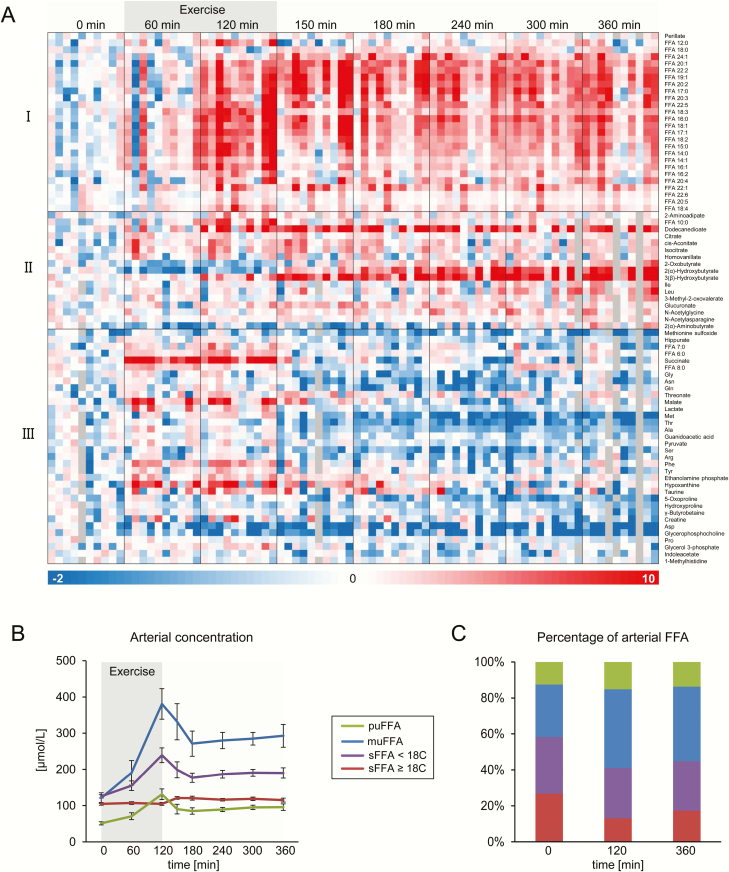
Effects of exercise on systemic concentrations of metabolites detected in plasma using CE-TOF/MS and UHPLC-Q-TOF/MS in the hepato-splanchnic exercise study. 2A: Metabolites significantly affected by exercise on the arterial (systemic) level, clustered by Spearman rank-order correlation. Each column represents unit variance (UV)-scaled, mean-centered values from 1 individual. 2B: concentration (mean ± standard error [SEM]) and 2C: percentages of free fatty acids (FFA), summed up according to chain length and degree of saturation (Abbreviations: mu, mono-unsaturated; pu, poly-unsaturated; s, saturated FFA). Only FFA with a chain length of more than 10 carbon atoms, from the UHPLC-Q-TOF/MS analysis, were included.